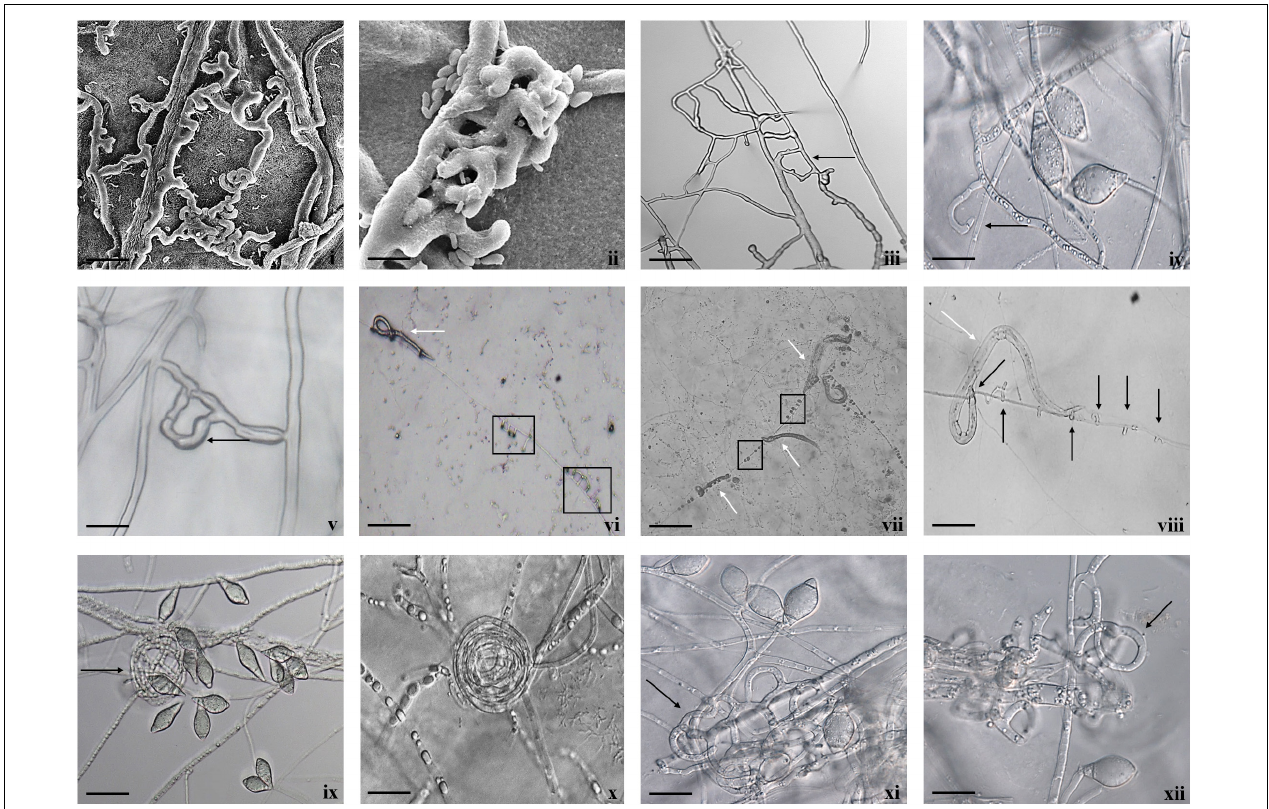
FIGURE 2 | Diversity of trapping structures of A. thaumasia At_RK. (i,ii) Scanning electron micrographs showing process of trap formation of adhesive two-dimensional (2D) network (scale bar = 20, 5 µ m), ( iii ) adhesive 2D (scale bar = 50 µ m), (iv,v) vegetative hyphae along with an initial branch forming a loop (black arrow) by turning around to meet a peg formed on parent hypha (scale bar = 50, 20 µ m), (vi–viii) non-constricting rings (black arrows), capturing nematodes (white arrows), (ix,x) non-constricting rings (scale bar = 20 µ m), (xi,xii) 3D adhesive network (scale bar = 20 µ